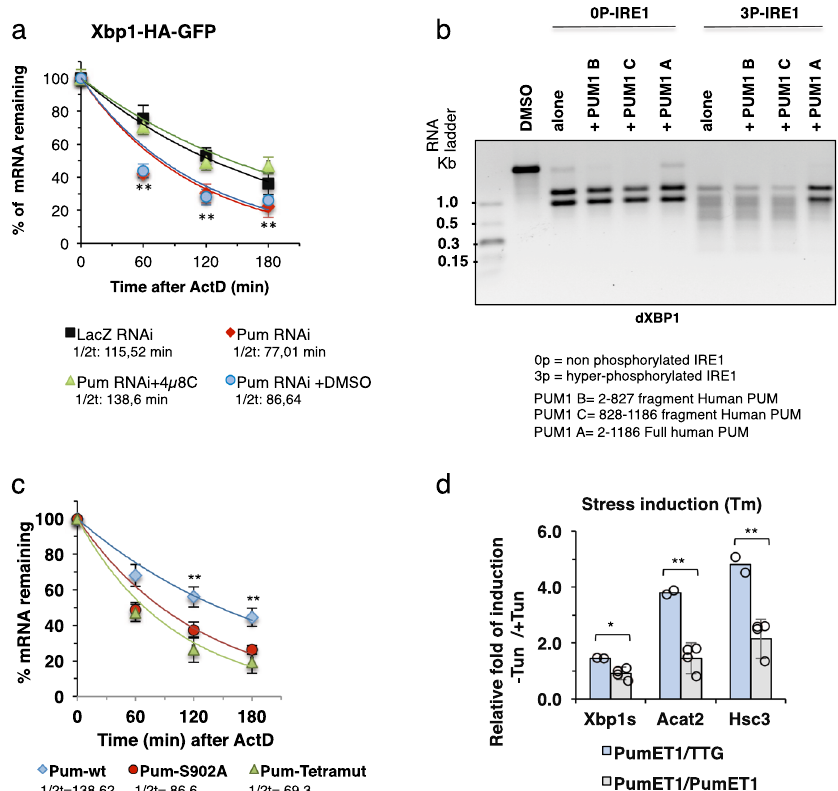
Fig. 5 Pumilio protects Xbp1 mRNA from regulated Ire1-dependent decay. a Control S2 cells (LacZ RNAi) were compared to cells treated with Pum RNAi and Pum RNAi treated with 4 μ 8C (100 μ M), an inhibitor of IRE1 endoribonuclease activity, or vehicle control (DMSO). Total RNA was isolated after ER stress (5mM DTT) in the presence actinomycin D (5 μ g/ml). qRT-PCR analysis was used to determine mRNA levels using speci fi c primers for gfp and rp49 . Results are presented as mean ± SD of %mRNA remaining. Half-lives were calculated by regression analysis. LacZ RNAi (black); PumRNAi (red); 4 µ 8C (green) and DMSO (blue). n = 3 biological independent experiments. one-way ANOVA coupled with Tukey ’ s post hoc test (1 h: ** p = 0.0010053 for lacZ RNAi, PumRNAi, PumRNAi DMSO, PumRNAi + 4 µ 8C; 2 h: ** p = 0.0083911 for LacZ RNAi vs PumRNAi; ** p = 0.0090392 for PumRNAi vs PumRNAi +